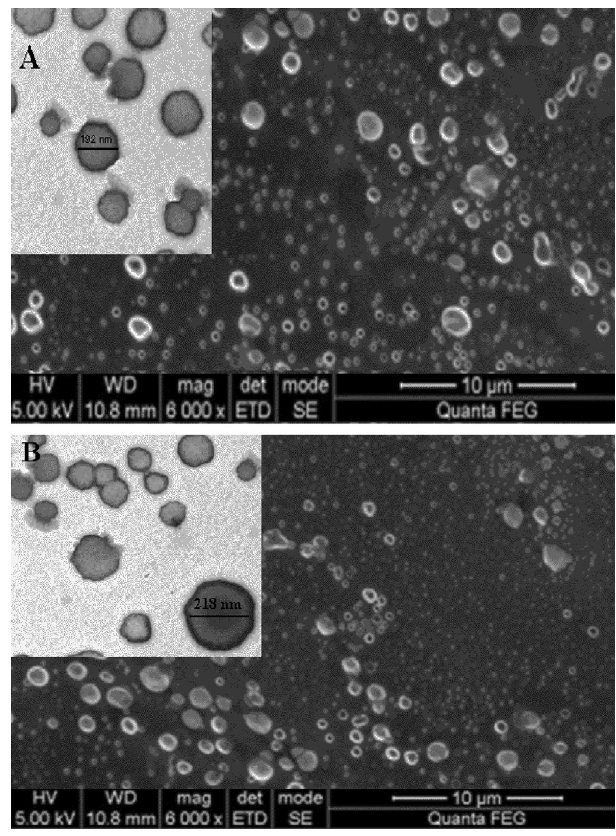
Figure 1. ( A ) F1 formulations of Niosome-encapsulated Imipenem. ( B ) F2 formulations of Niosome- encapsulated